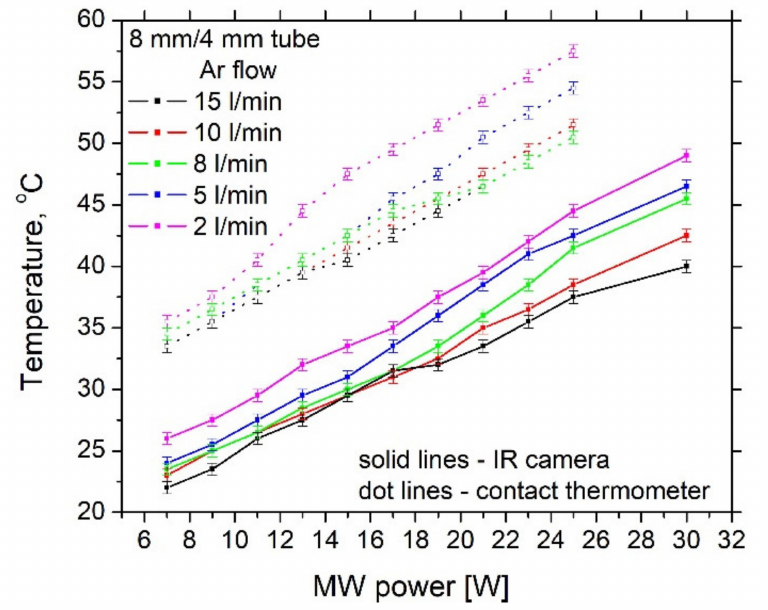
Figure 10. Effect of argon flow rate on the temperature for 8 mm/4 mm discharge